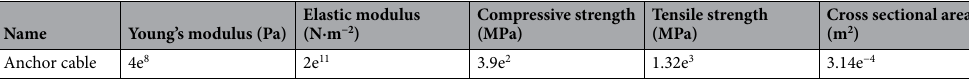
Table 2. Parameters of bolt element.